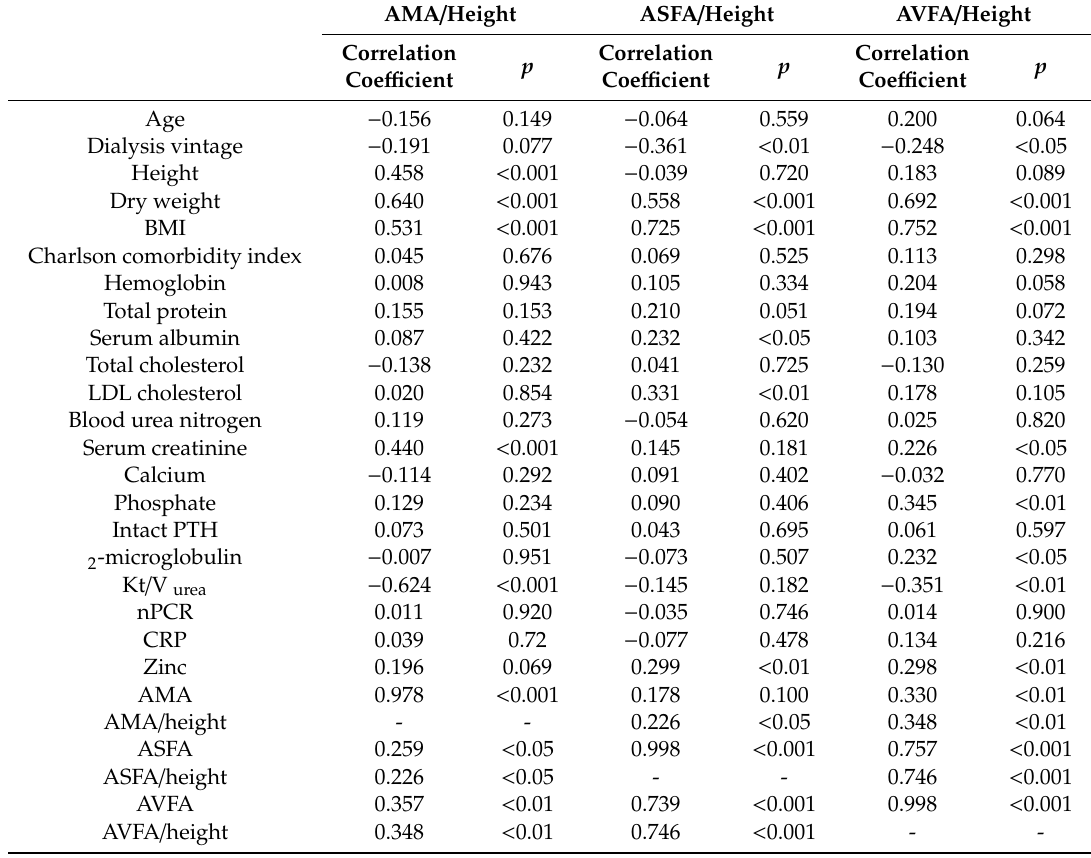
Table 2. Correlations between AMA standardized for height (AMA / height), ASFA standardized for height (ASFA / height), AVFA standardized for height (AVFA / height) and clinical